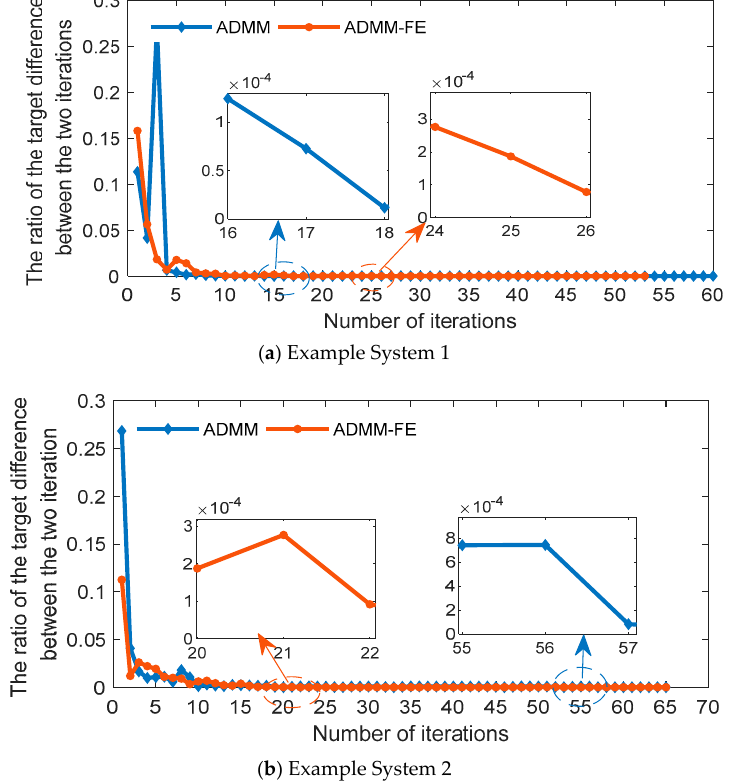
Figure 3. Unbalanced amount of objective function.